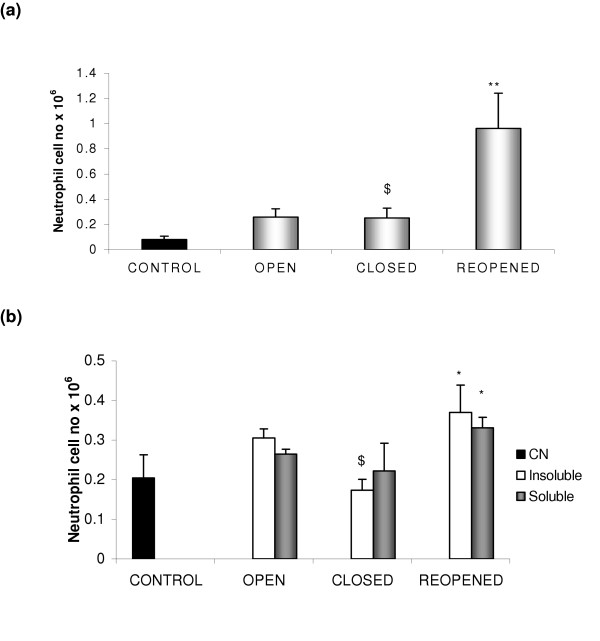
The mean neutrophil number in bronchoalveolar lavage from rat's 18 hr after exposure to either (a) total aqueous extracts or (b) the soluble or insoluble fractions of aqueous extracts of PM10 samples collected before, during and after the steel plant closure. Control animals were instilled with saline. Values represent the mean of (a) 6 and (b) 3 rats ± SEM (** p < 0.01 and * p < 0.05 to control, $ p < 0.05 closed to reopened